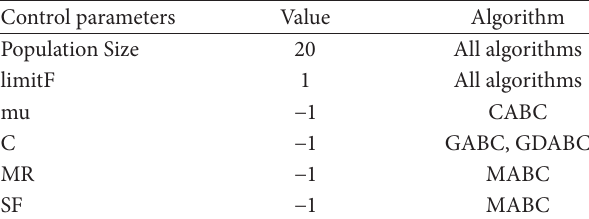
Table 2: Parameter setting for ABC